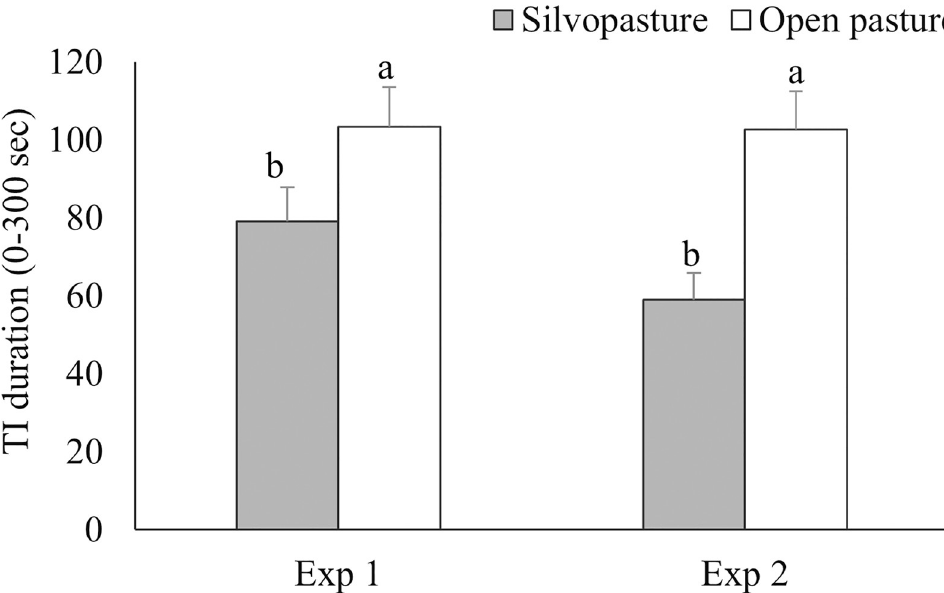
Fig 2. Means for tonic immobility (TI) duration ( ± SEM) for broilers raised in silvopasture or open pasture plots on day 38 in Experiment 1 (n = 159) and on day 37 of age in Experiment 2 (n = 156). AB Raw means within Experiment 1 with uncommon superscripts differ at p < 0.10. ab Raw means within Experiment 2 with uncommon superscripts differ at p < 0.05.